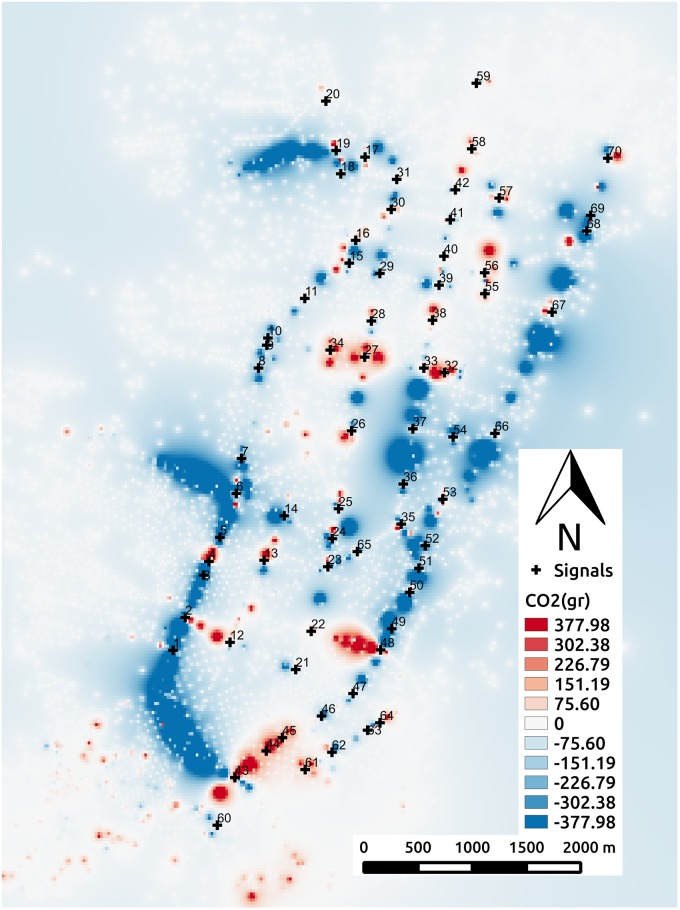
Change in CO2 emissions.